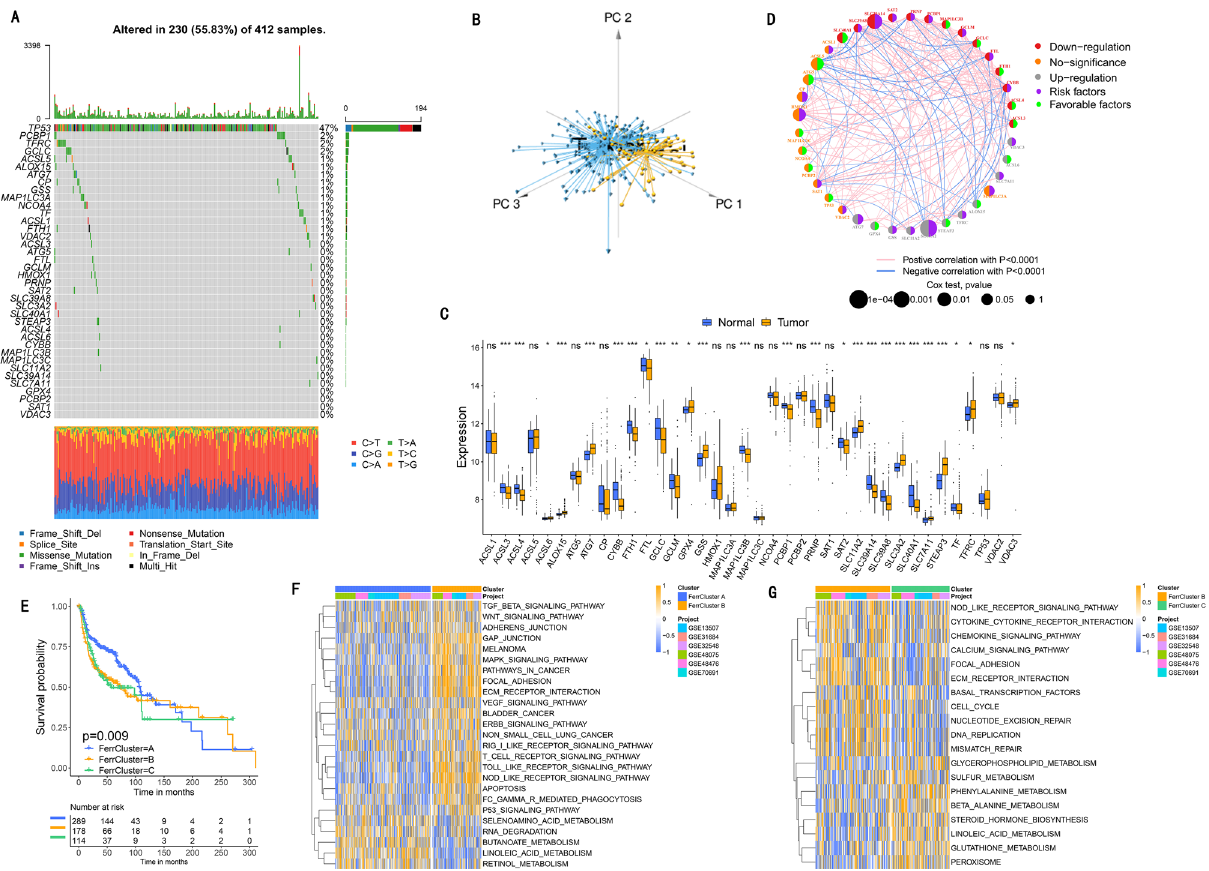
Figure 2. The genetic and expression variation landscape of ferroptosis-related genes related to bladder cancer. ( A ) The mutation frequency of 38 ferroptosis-related genes in 412 patients who have bladder cancer from TCGA dataset. Each patient was shown in individual column, among which TMB was shown in the bar graph on top, with the mutation frequency of each regulator shown as number on the right, the ratio of each variant type was shown in the bar graph on the right, and conversion rate of each sample was shown in the stacked bar chart below. ( B ) Analysis performed for principal component of 38 ferroptosis-related genes’ expression profiles to tell apart tumors and normal samples in TCGA dataset. Tumors were marked in blue and normal samples in yellow ( C ) The transcripts of 38 ferroptosis-related genes on control samples and bladder cancer. Yellow shows tumor and blue represents the normal. The interquartile range of values was represented by the boxes’ upper and lower ends, the median value is represented by the lines in the boxes, and outliers were shown by dots in black. ( D ) Interaction between ferroptosis-related genes in bladder cancer. The effect of each gene on the prognosis is indicated by the size of circle, and by Log-rank test. the scales of P value were less than 0.0001, 0.0001, 0.01, 0.05 and 0.1. In the circle, purple dots indicated risk factors of prognosis while green dots indicated protective factors of prognosis. The interaction between genes were shown by linking lines and the correlation strength between genes were shown by thickness. Blue indicates negative correlation and red indicates positive correlation. ( E ) Analysis supported by Kaplan–Meier curves of survival for these ferroptosis subtypes regarding 481 patients who have bladder cancer from six GEO datasets (GSE13507, GSE31684, GSE32548, GSE48075, GSE48476, GSE70691), including 289 patients in Ferrcluster-A, 178 patients in Ferrcluster-B, and 114 patients in Ferrcluster-C. A great difference of the survival of these ferroptosis subtypes was shown by the Kaplan–Meier curves, along with Log-rank p value, which is 0.009. Compared to other two Ferrclusters, Ferrcluster-A is significantly better on survival. ( F – G) Analysis of GSVA enrichment, which suggested the status of biological pathways’ activation in different ferroptosis subtypes. These biological processes were visualized by heatmap, with activated pathway shown in brown and inhibited pathway shown in blue. For sample annotations, it used the bladder cancer datasets. ( F ) Ferrcluster-A versus Ferrcluster-B, and ( G ) Ferrcluster-B versus Ferrcluster-C. The value of p is graphically shown by asterisks, of which * means that p is less than 0.05, ** means less than 0.01 and *** means less than